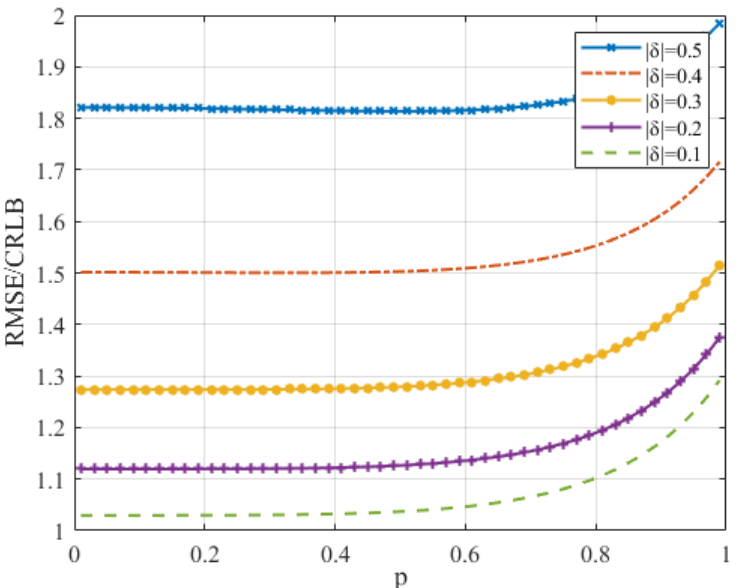
Figure 2. The RMSE/CRLB of the proposed algorithm versus p for different values of δ when the SNR = 0 dB and N = 512.